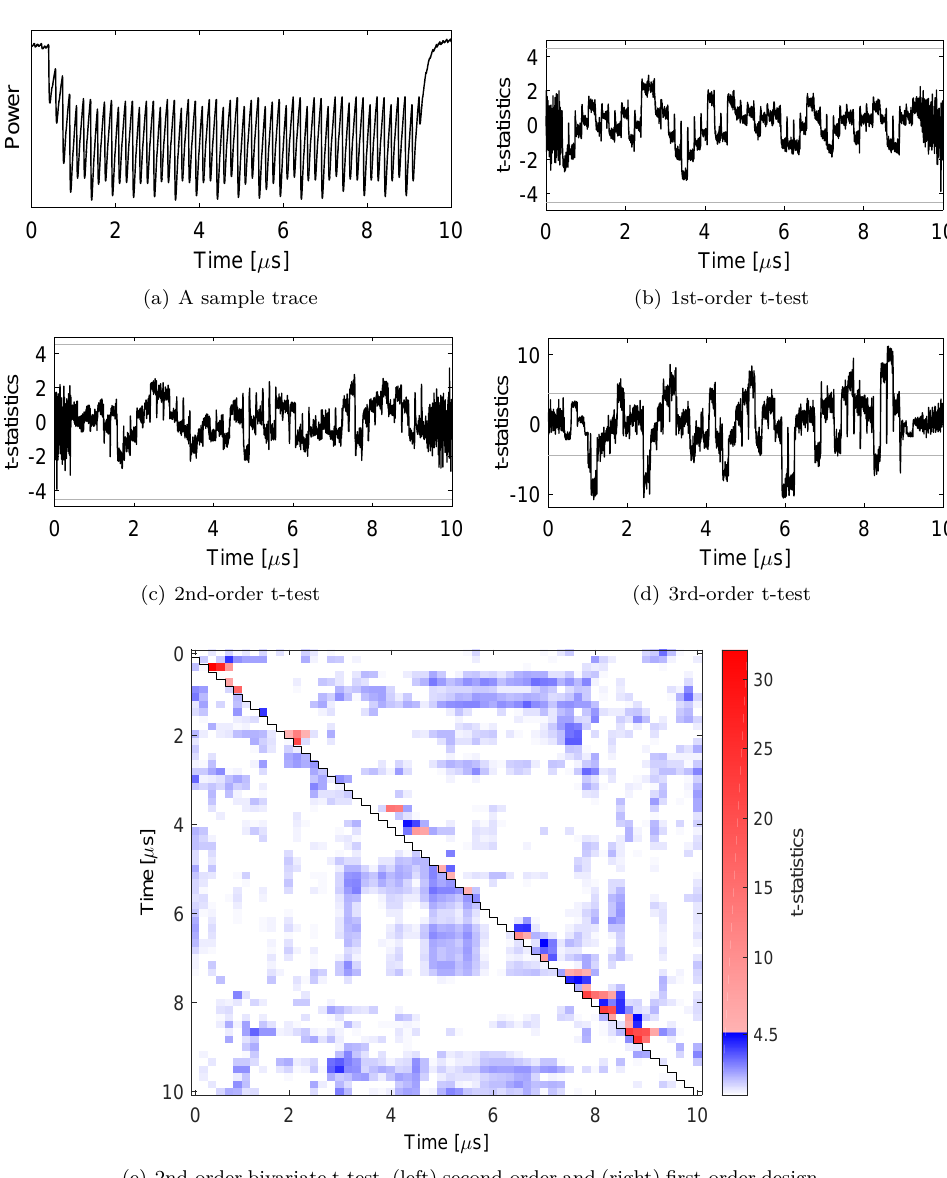
Figure 6: Experimental analysis of our second-order secure Keccak - f [200] design, 100 million